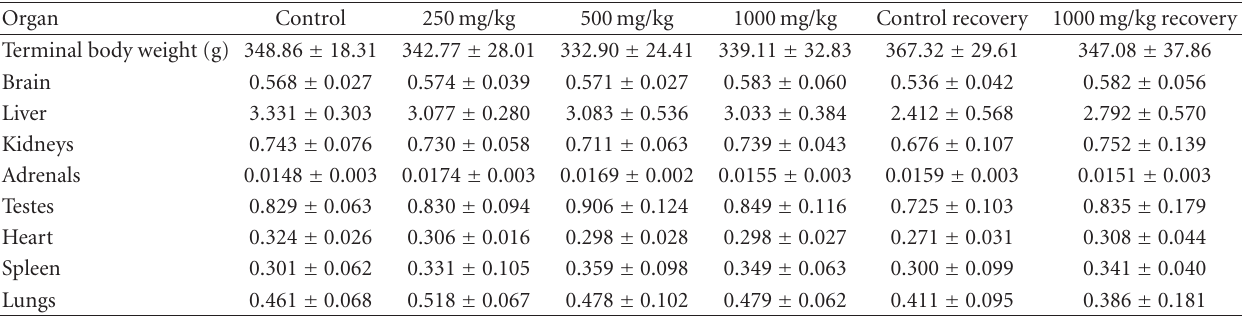
Table 8: Relative organ weights (% of fasting body weight; mean ± SD) in male rats treated with Zigbir (cid:2) orally for 90 days. Organ Control